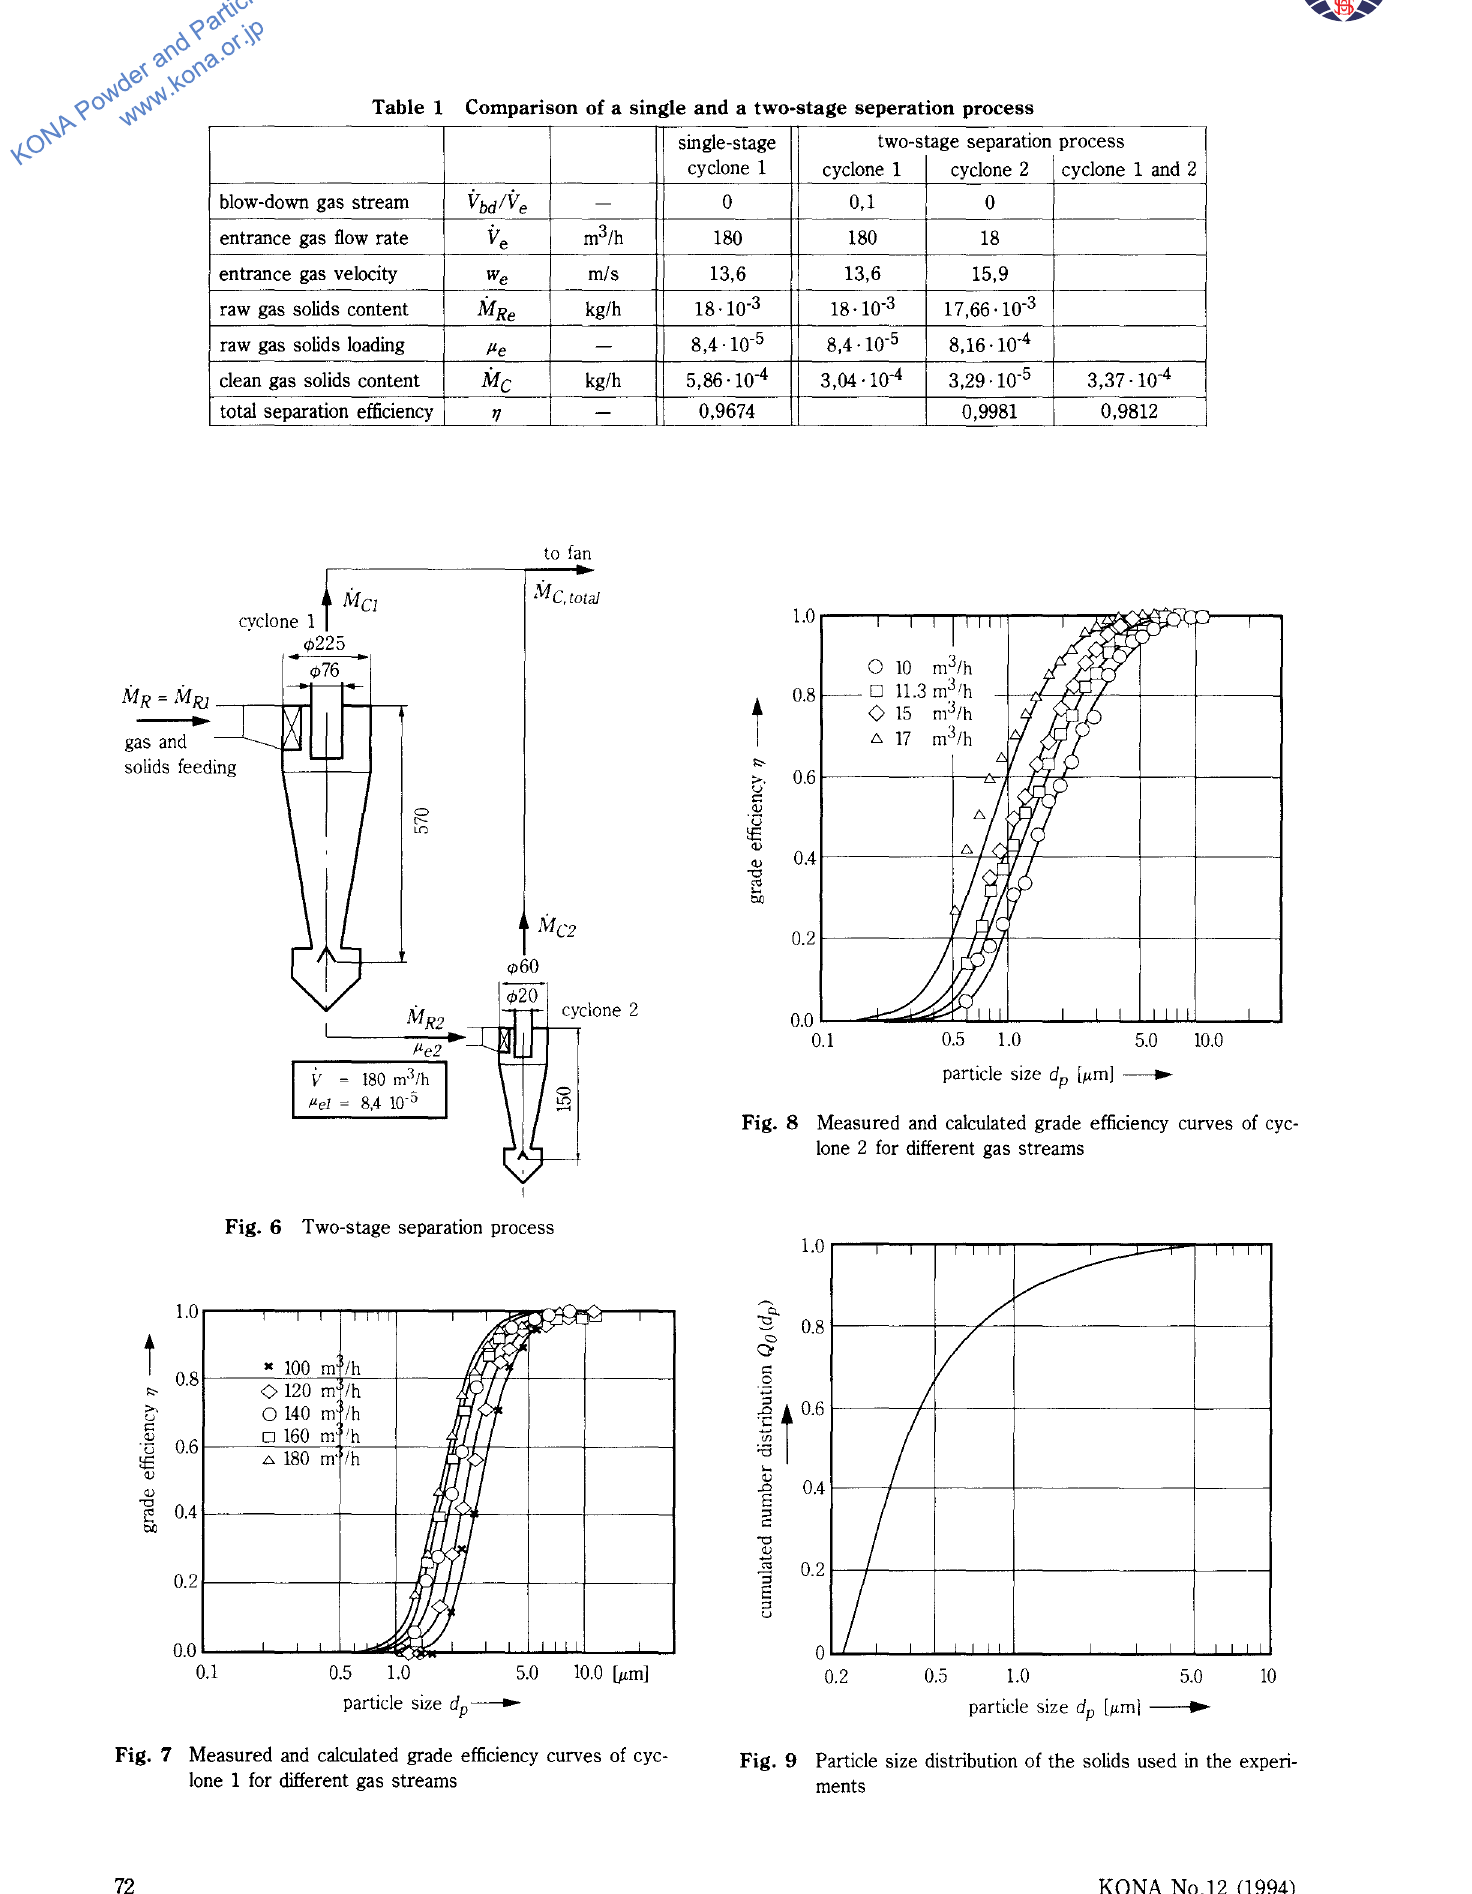
Fig. 9 Particle size distribution of the solids used in the experi